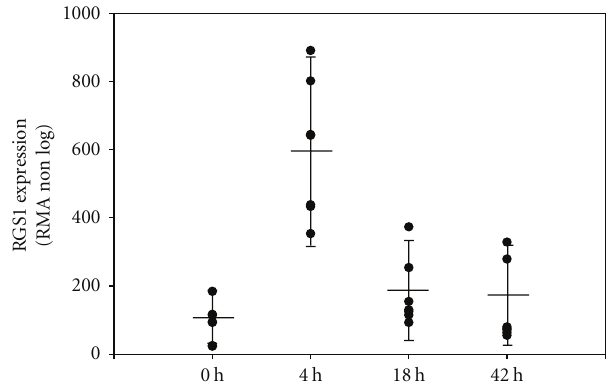
Figure 4: Induction of RGS1 in MS patients after a single dose of Betaseron. Seven patients with clinically defined MS were selected for study. Patients had been on treatment for an average of 1.8 ± 0.8 years and were free of exacerbations for 3 months before and after blood collection. PBMCs were isolated and RNA expression analyzed using GeneChip technologies described in Section 2. Betaseron induction of RGS1 gene expression is presented as RMA values. RGS1 (A ff ymetrix RGS1 probe set 202988 s at) was demon- strated to be strongly up-regulated reaching a maximum level 4 hours after administration of Betaseron. The time of blood draw (0 hours = wash-out period before administration of Betaseron, and 4, 18, and 42 hours post-Betaseron administration) is shown on the x -axis. RGS1 expression (RMA non-log) is presented as a scatter plot showingthe response ofeach patient including the mean expression (solid bar) for all MS patients at each time point. All patients received a pharmacological dose of Betaseron (250 μ g/mL; 8M